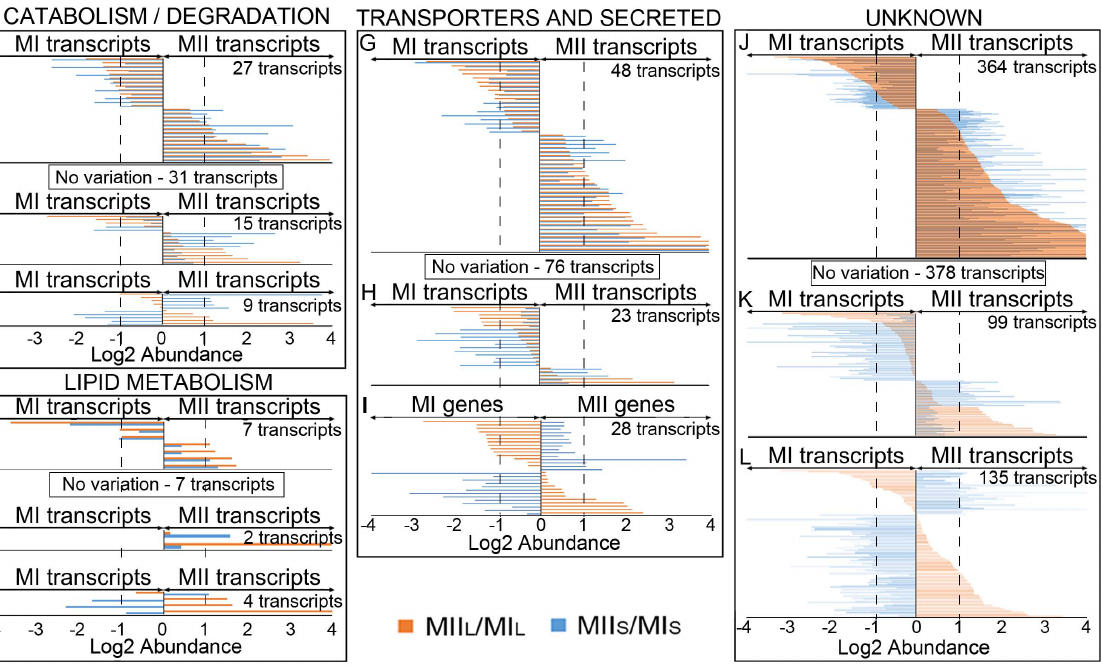
Figure 5. Transcripts abundance values (log2 MII/MI) grouped in functional categories (continuation). Functional categories: catabolism and degradation; lipid metabolism; transporters and secreted (ABC transporters, transporters and secreted proteins); genes with unknown function. Dashed lines indicate the limit for considering abundance variations significant (log2 abundance 6 1).